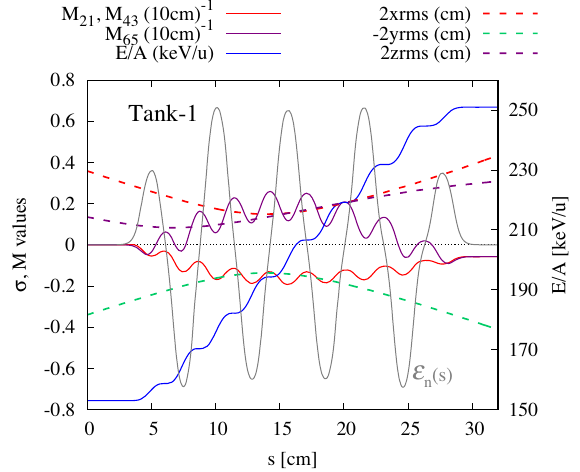
FIG. 9. TRANSOPTR computed elements M 21 , M 43 , and M 65 (solid lines) across DTLTank-1. Optimum acceleration to E=A ¼ 0 . 251 MeV = u is shown, where the energy gain (blue, right y axis) is monotonous, minimizing longitudinal restoring forces, which in turn reduces transverse rf focal effects. The plot also shows the ( x , y , z ) 2 rms envelopes, each as dotted lines. The scaled value of Tank-1 E n ð s Þ is shown in grey.